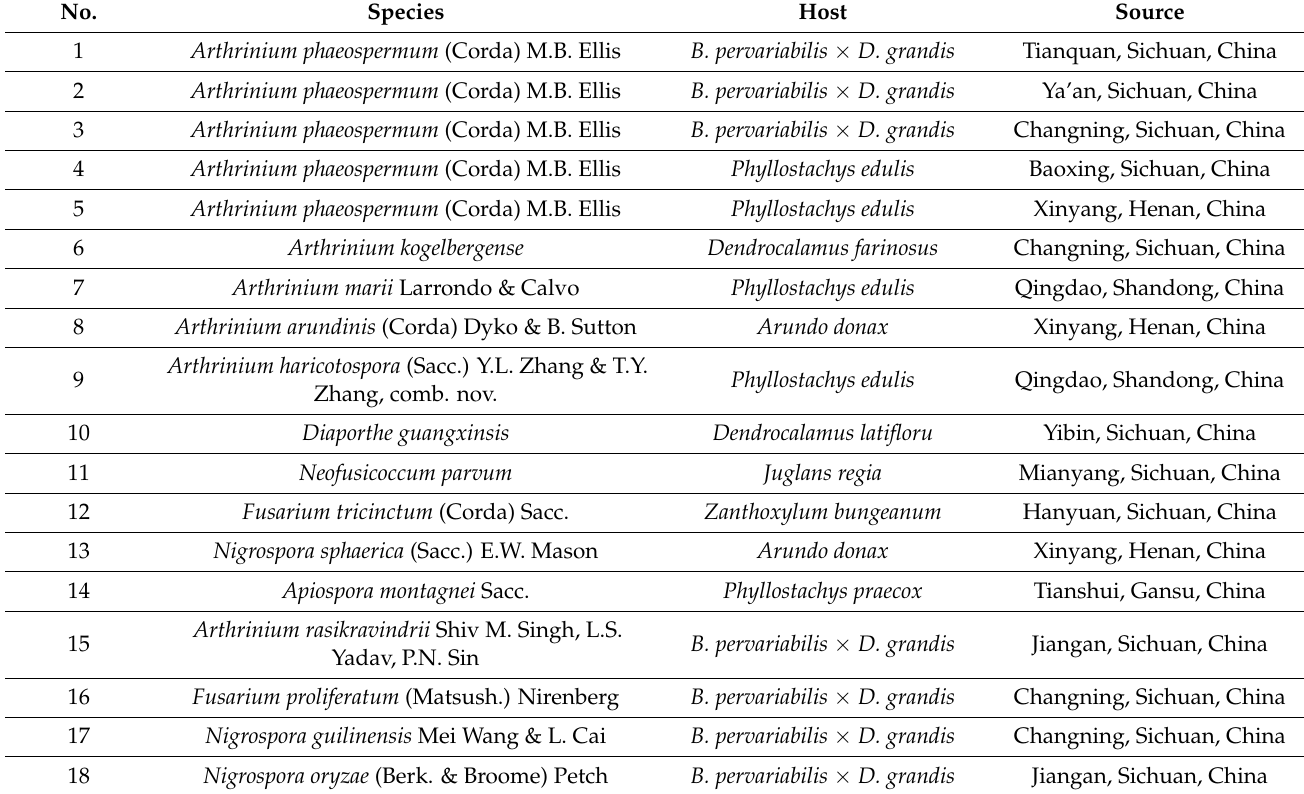
Table 1. Strains used in this study to test the specificity of seminested PCR, qPCR, and LAMP